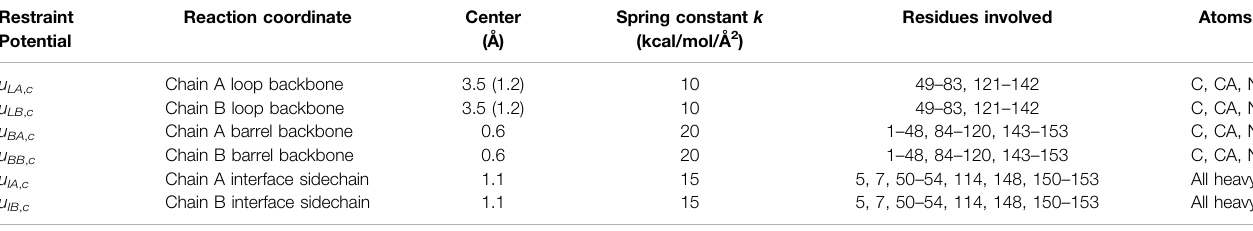
TABLE 4 | Conformational restraint parameters. The restraint parameters for WT Cu,Zn (SS) SOD1 are given inside parentheses when different from the apo parameters. Otherwise, they are the same. Restraint